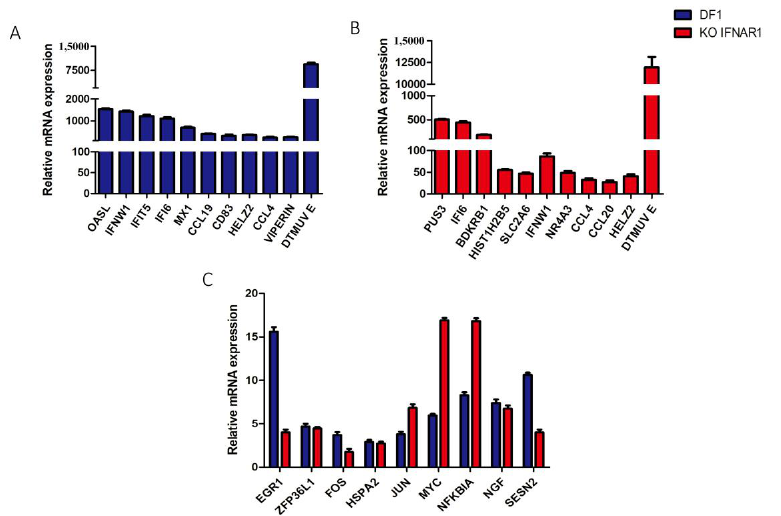
Figure 6. Validation of up-regulated genes in DTMUV-infected DF-1 and KO-IFNAR1 cells by RT-qPCR. ( A ) Fold-induction of the top 10 significantly up-regulated genes in DF-1 cells infected with DTMUV. ( B ) Fold-induction of the top 10 significantly up-regulated genes in KO-IFNAR1 cells infected with DTMUV. ( C ) Fold-induction of EGR1, ZFP36L1, FOS, HSPA2, JUN, MYC, NFKBIA, NGF and SESN2 in DF-1 and KO-IFNAR1 cells infected with DTMUV. As EGR1, ZFP36L1, FOS, HSPA2, JUN, MYC, NFKBIA, NGF and SESN2 were up- regulated in both DTMUV-infected DF-1 and KO-IFNAR1 cells, the up-regulation of these